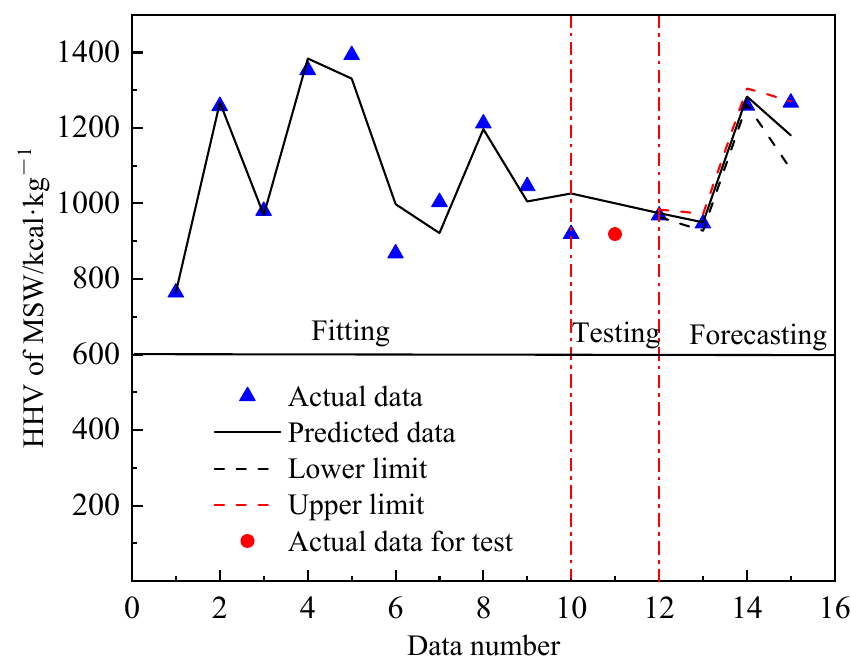
Figure 3. Forecasting of MSW’s HHVs using POBGM (1, 5) at 95% PI. Data Number 11, of which the HHV is 947.5 kcal kg ‐ 1 , is outside the prediction curve